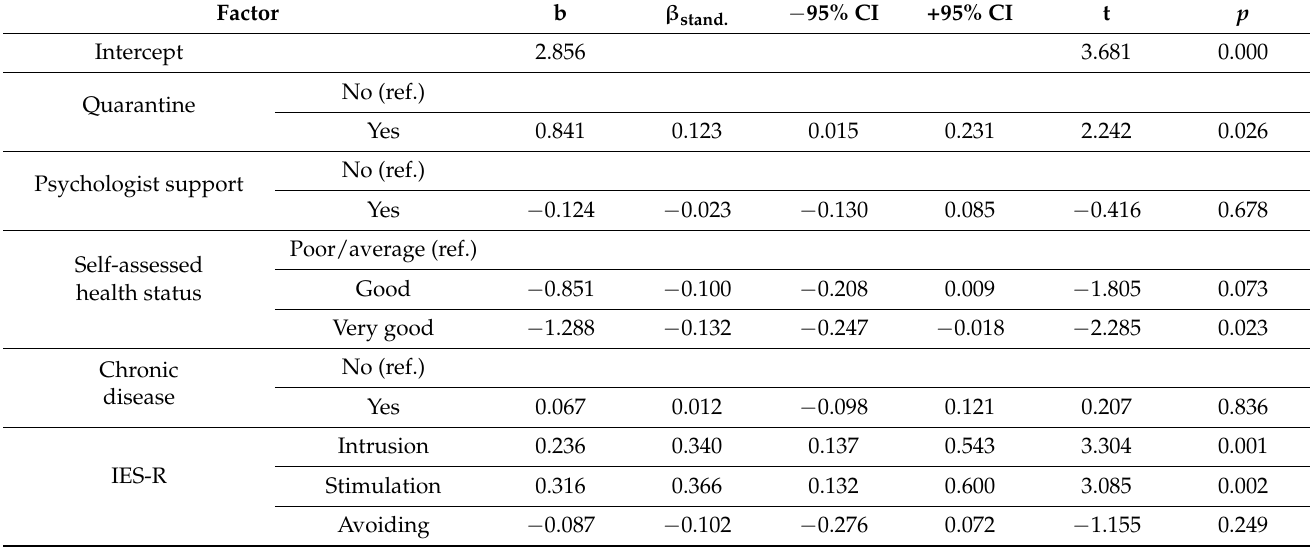
Table 3. Effect of the self-assessment of health, quarantine, psychological support, presence of chronic diseases and dimensions of the Impact of Event Scale—Revised (IES-R) on the level of anxiety according to GAD-7 (model IV).